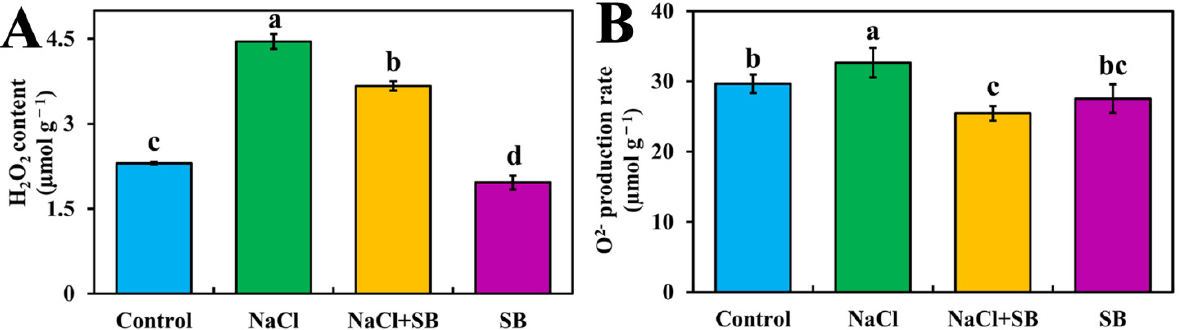
Figure 6. Effect of MAPK inhibitors SB203580 on H 2 O 2 and O 2 − content during salt stress. ( A ) H 2 O 2 content, ( B ) O 2 − content. The values (means ± SE) are the averages of three independent experiments ( n = 15). Bars not sharing the same letters indicate statistically significant differences according to Duncan’s multiple range test ( p < 0.05). DAB staining, NBT staining.